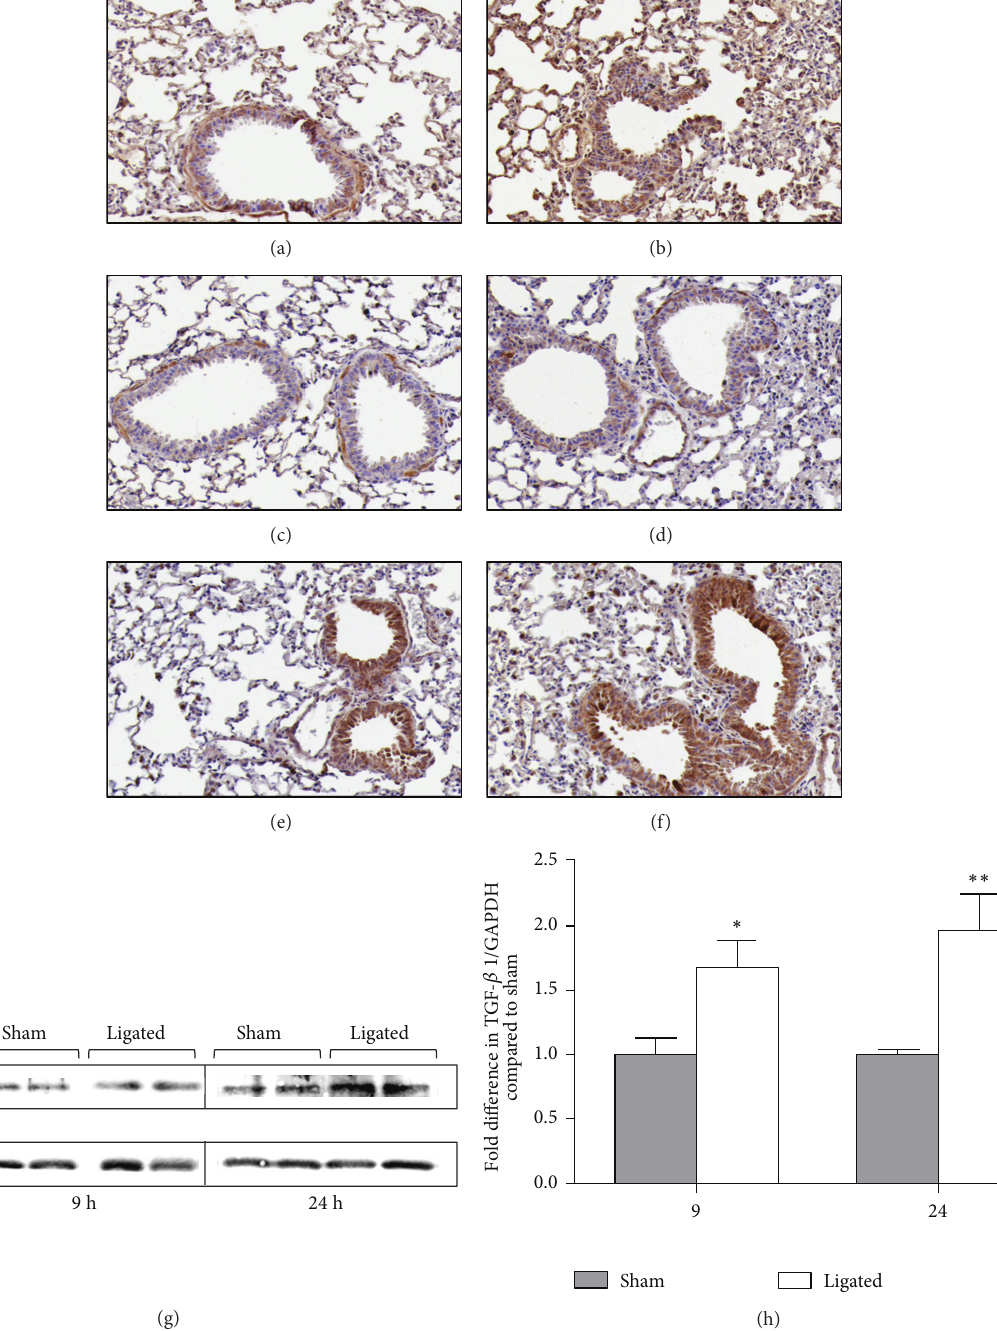
Figure 1: Expression of three different isotypes of TGF- 𝛽 in the lungs. Immunostaining of TGF- 𝛽 1 (a and b), TGF- 𝛽 2 (c and d), and TGF- 𝛽 3 (e and f) levels in lung tissue from sham controls (a, c, and e) and 9 h after acute pancreatitis induction (b, d, and f). Positive staining is visualized in brown by DAB and counterstained in blue by haematoxylin. Results from one representative of eight samples per group are shown. Original magnification, × 20. Western blot analysis of TGF- 𝛽 1 protein levels in lung extracts of sham-operated and ligated animals at time points indicated (g). Two of five similar analyses per group are shown. Graph shows densitometry evaluation of fold difference in TGF- 𝛽 1 intensity compared to sham control and represents mean ± SEM of five samples per group (h). ∗ 𝑃 < 0.05 ; ∗∗ 𝑃 < 0.01